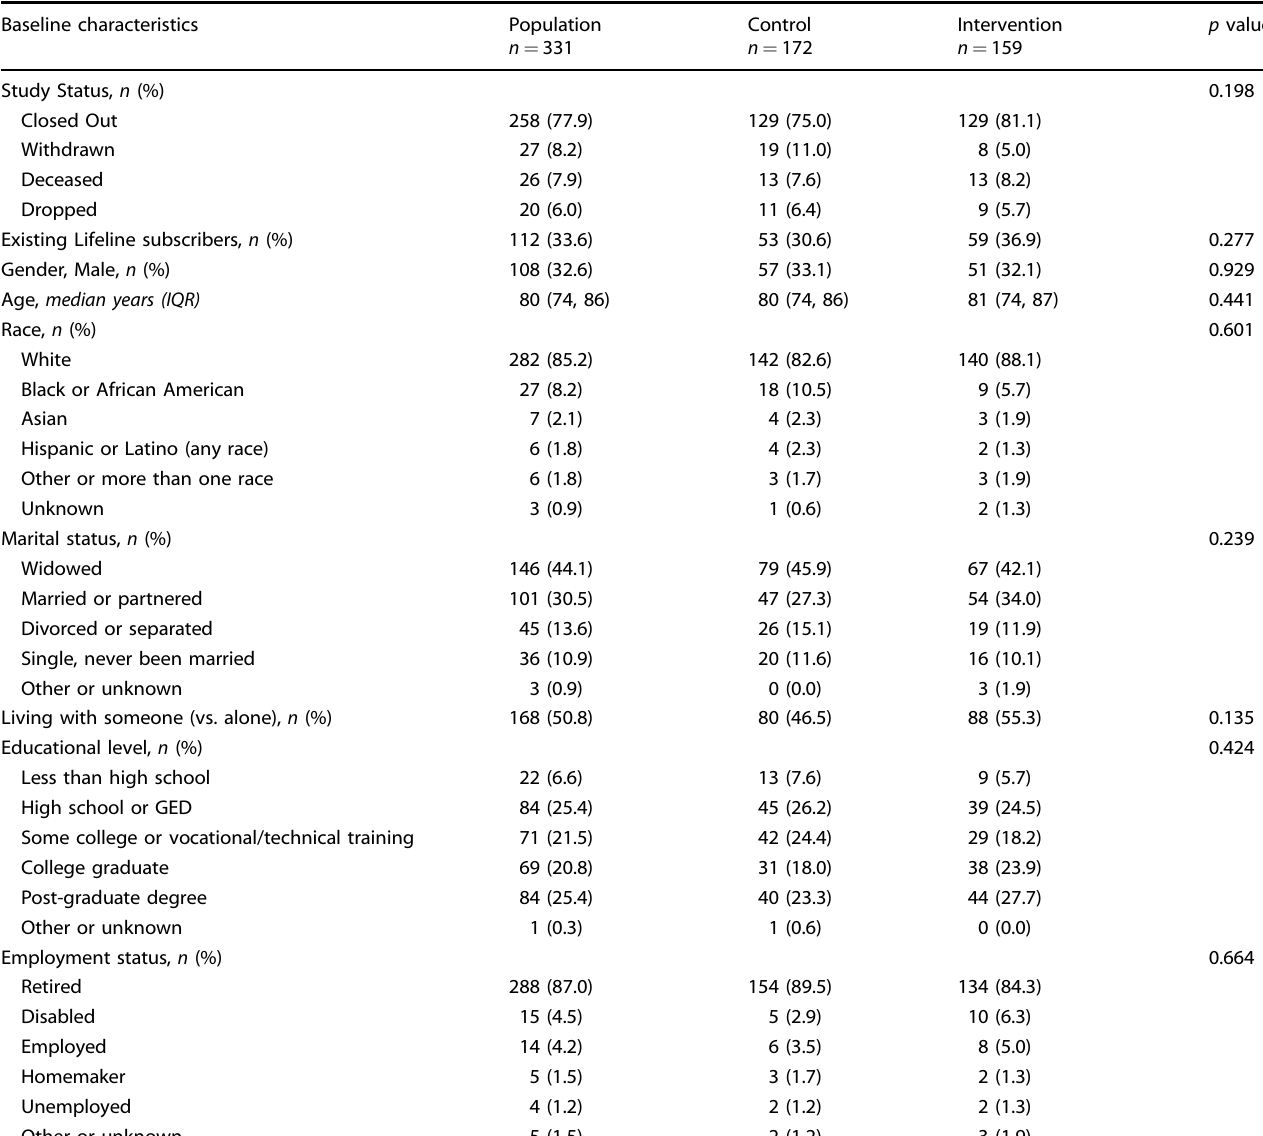
Table 1. Baseline characteristics by group —